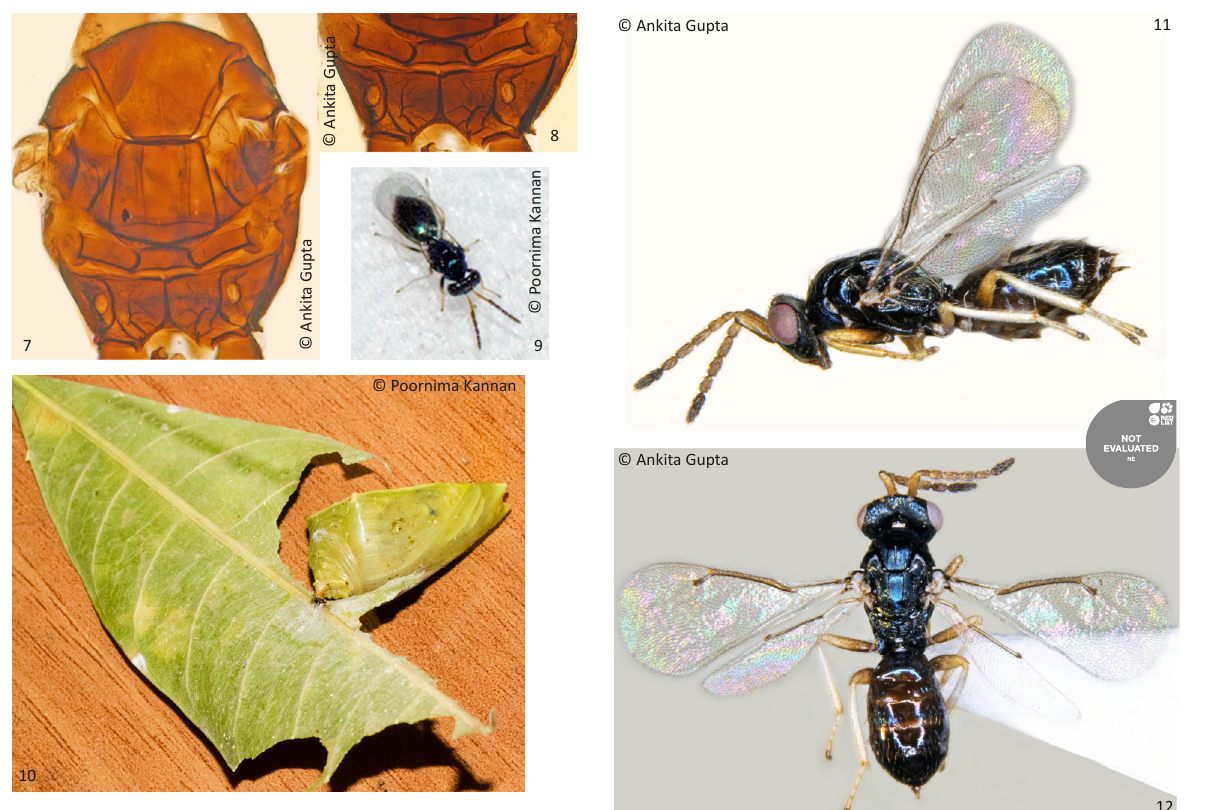
10 males, Bangalore, Karnataka, India; ex. pupa of Euthalia aconthea meridionalis Fruhstorfer on Mangifera indica L.; coll. Poornima Kannan. Female Body length 2.48−2.68 mm. Body black with metallic blue-green reflection (Image 1). Eyes brown. Ocelli red brown. Antenna dark brown with scape and pedicel paler (Image 3). Tegula dark brown. Wings hyaline, veins brown. Femora black with metallic shine, apices pale yellow; fore tibia and tarsi pale yellow, mid and hind tibiae and tarsi off white; pretarsi brown.